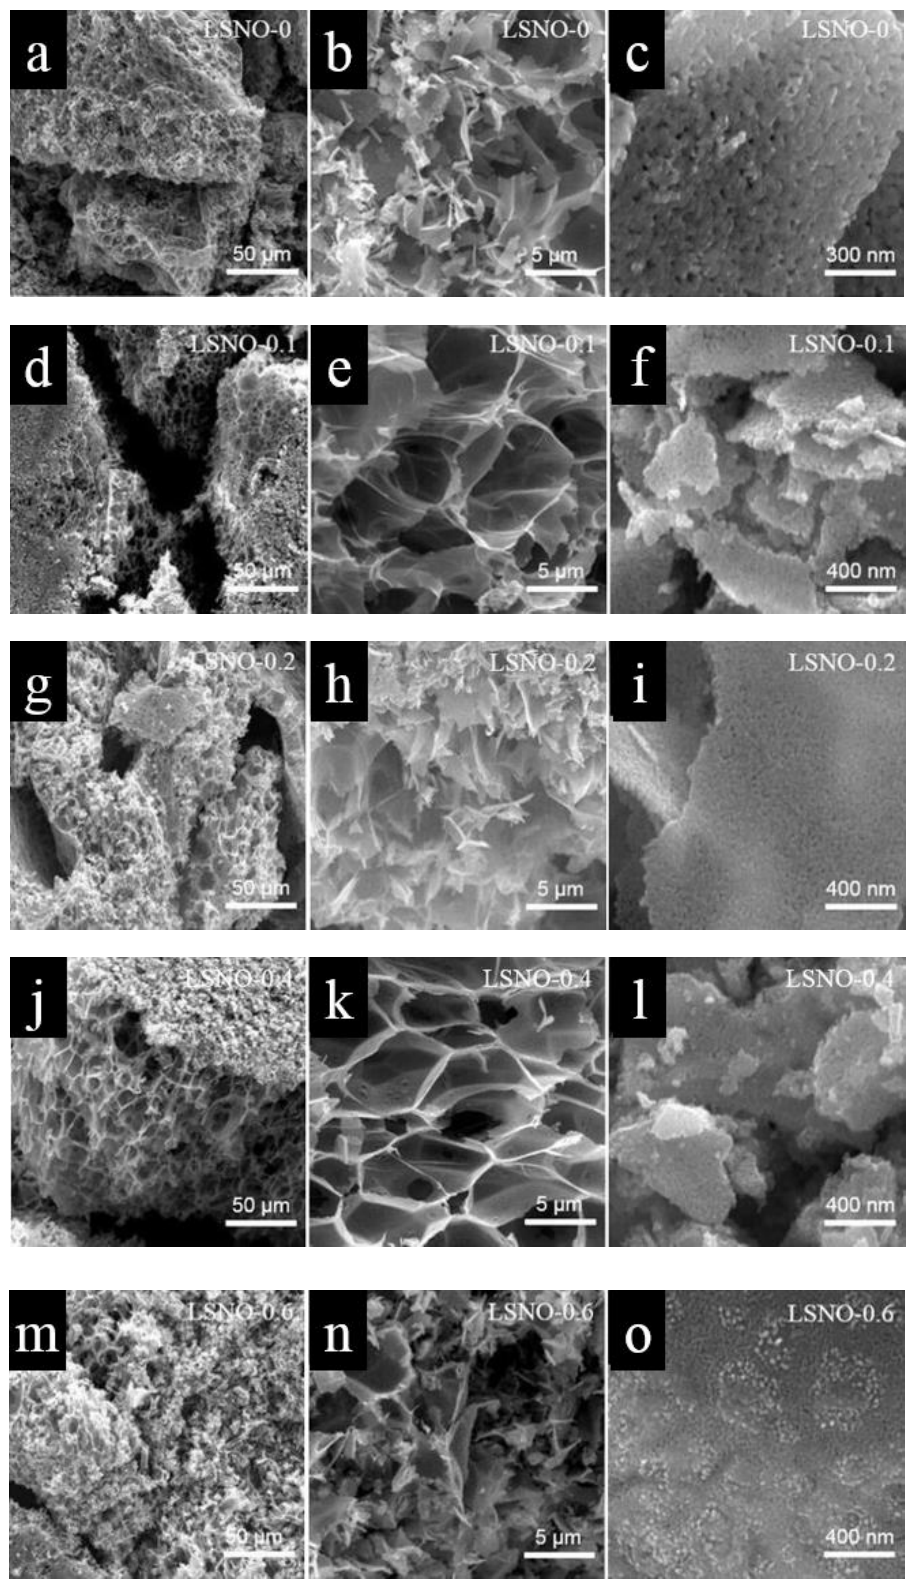
Figure 2. SEM images of LSNOs sample. ( a – c ) LSNO-0; ( d – f ) LSNO-0.1; ( g – i ) LSNO-0.2; ( j – l ) LSNO-0.4; ( m – o ) LSNO-0.6.